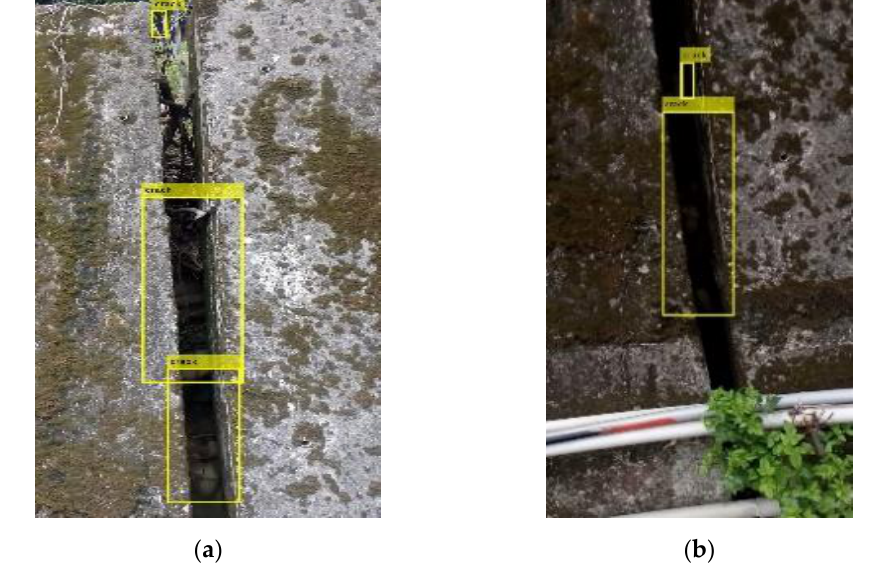
Figure 14. Non-dangerous crack detection results ( a ) the expansion joints case #1 ( b ) the expansion joints case #2 (The crack size is in the yellow box, and the data are given in Tables 1 and 2.) Table 1. Dangerous gap evaluation datasheet. The FPS of the detection process is 20–25 frames, and the reaction time is about 0.04 s. The film’s continuity is still maintained, and there are still a few misjudgments